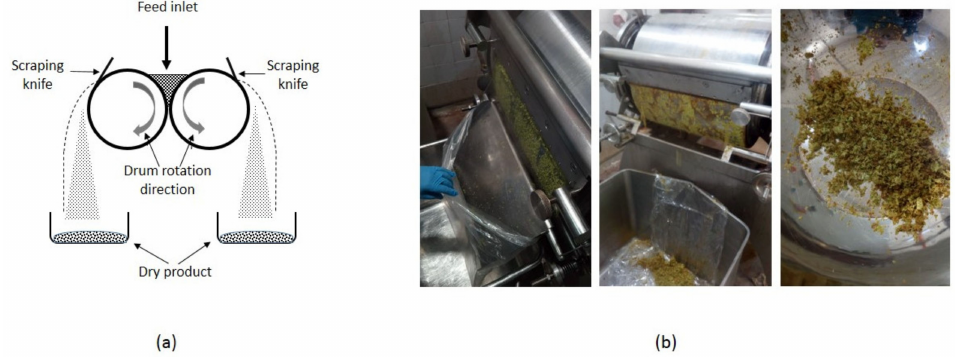
Figure 1. Double-drum dryer ( a ) operation scheme and ( b ) operation